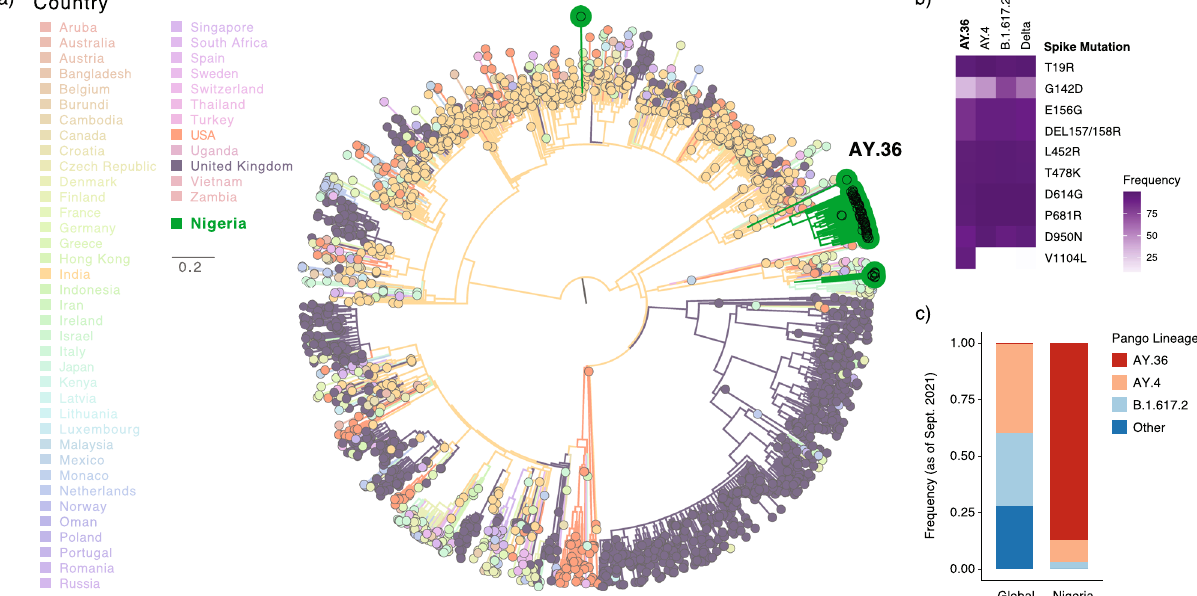
Fig. 3 Analysis of Oyo state Delta sequences compared to global Delta sequences. a ML phylogenetic temporal reconstruction of full genome Delta sequences obtained in this study and temporally sampled Delta global sequences from GISAID as of 3 August 2021. Branches and tips are colored by country. The clade corresponding to the AY.36 lineage is indicated. b Spike protein mutation prevalence across all Delta lineages and the 2 most frequent lineages (AY.4 and B.1.617.2) compared to AY.36 lineage. c Prevalence of the most frequent Delta lineages globally compared to the distribution in Nigeria where AY.36 lineage was the most prevalent. AY.36 was represented in the global distribution (only 0.2% of global sequences) for comparison purposes. Data for b and c was obtained from (https://outbreak.info/) 84 .